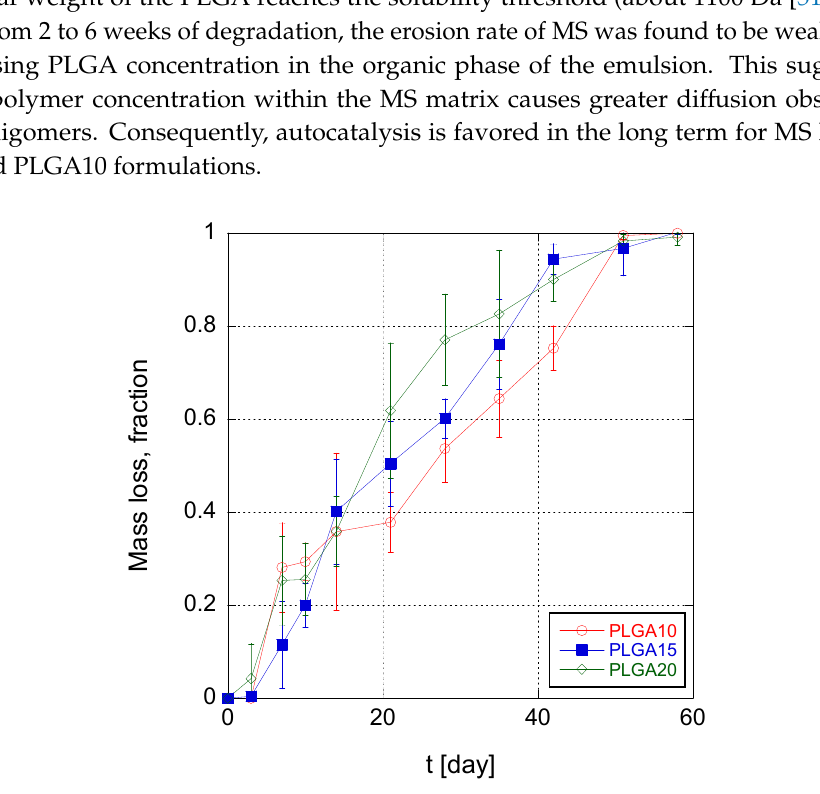
Figure 4. Time trend of mass loss of poly(lactic- co -glycolic acid) (PLGA) MS.